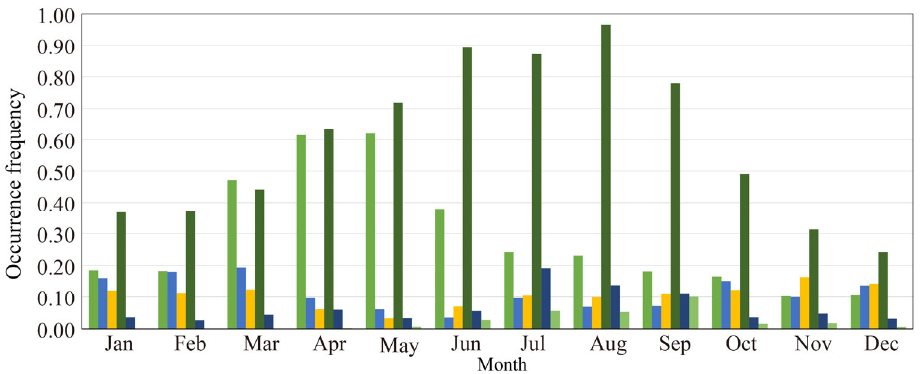
Figure 5. Monthly occurrence frequencies of aerosol subtypes for years 2007 to 2021.